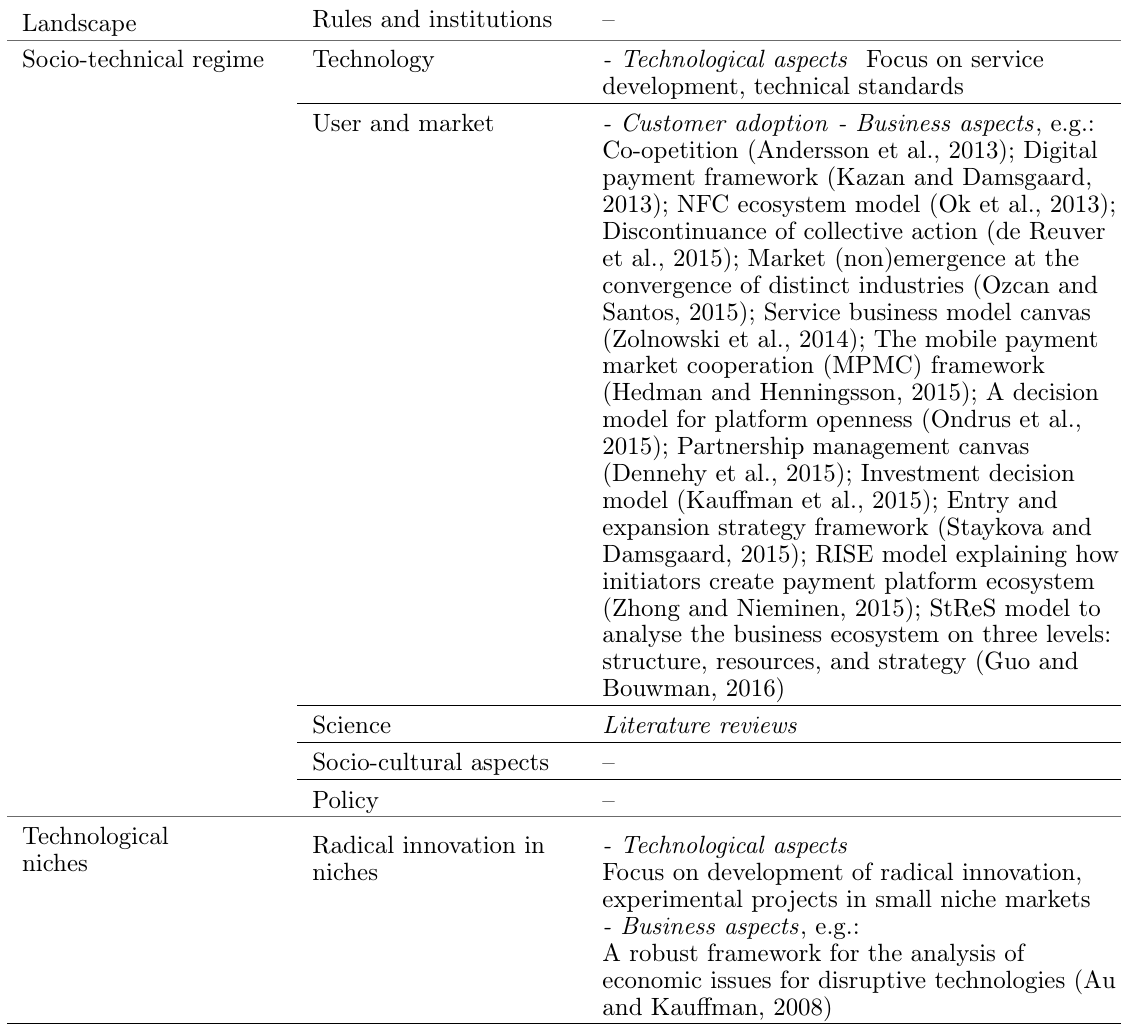
Table 21. A multi-level perspective on the research on mobile